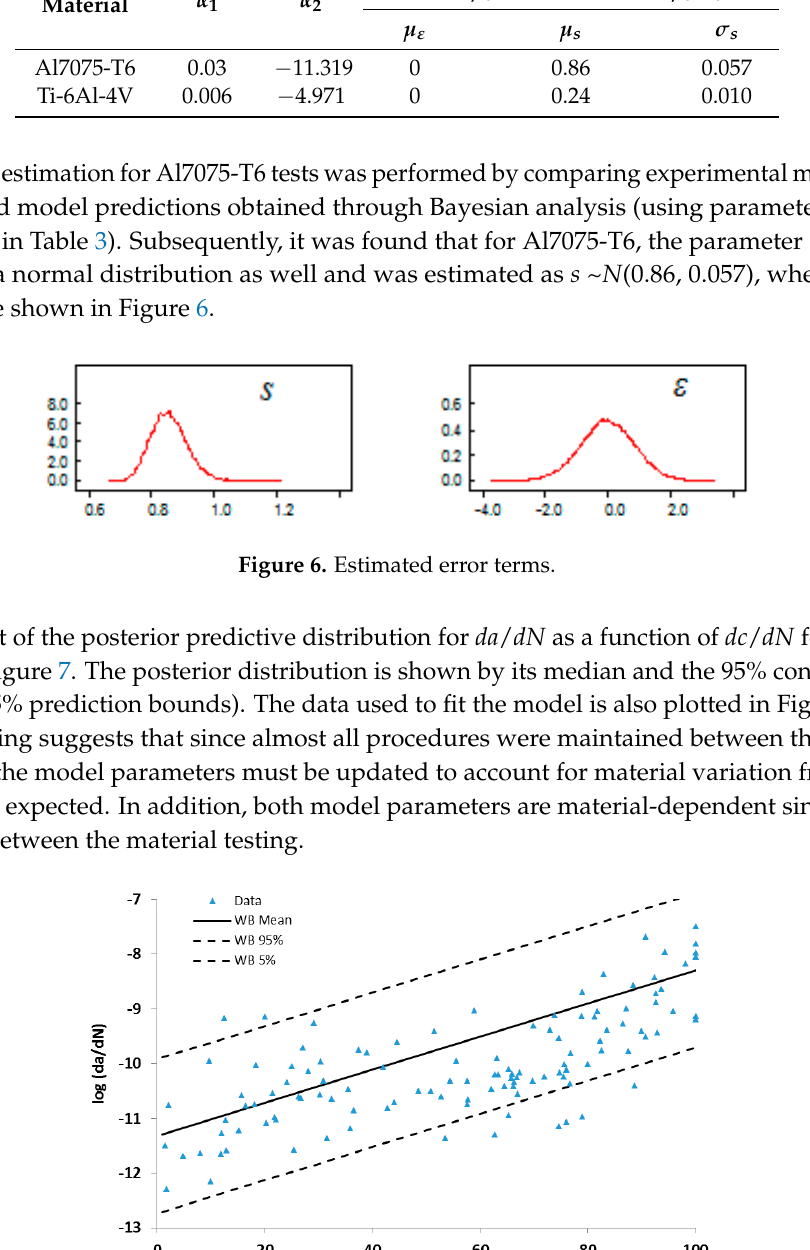
Figure 7. Posterior predictive AE model with the uncertainty bounds, material: Al7075-T6; WB indicates Bayesian regression analysis results using WinBugs.